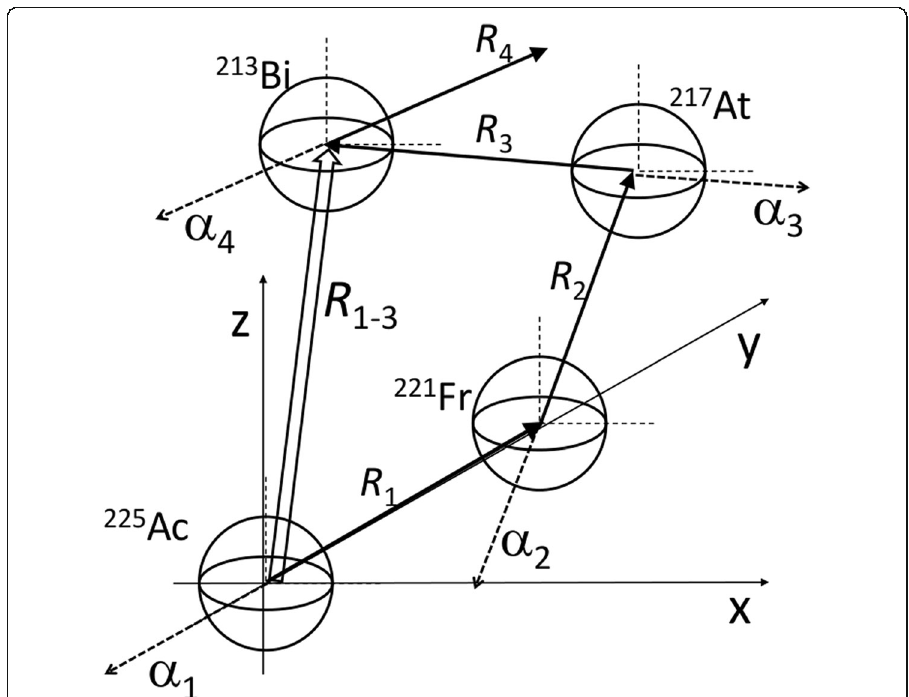
Fig. 5 A realistic scenario of an α -particle emission cascade must take into account that the α -emissions are isotropic and statistically not correlated. 225 Ac emits an α -particle in – γ -direction and the recoiling 221 Fr moves the distance R 1 in + γ -direction. The α -particle emitted by 221 Fr will most likely be emitted in a different direction, hence, the recoiling daughter nucleus 217 At recoils in a different direction by a distance R 2 . The subsequent α -decay will leave the 213 Bi in a distance R 217 At. In a 3-dimensinal space the distance 3 from the decaying R 225 Ac and the last daughter to be confined 213 Bi is usually much smaller 1-3 between the mother nuclide than R 1 + R 2 + R 3 ≈ 3